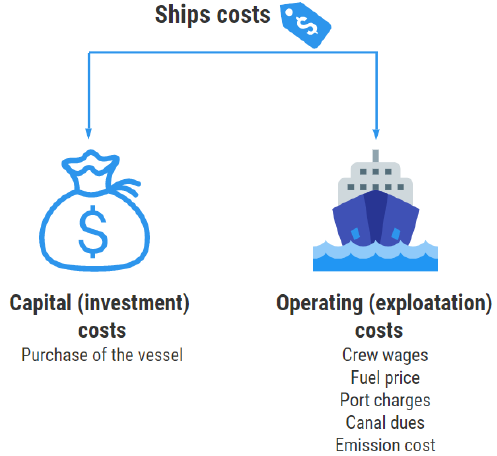
Figure 3. Ship cost model.